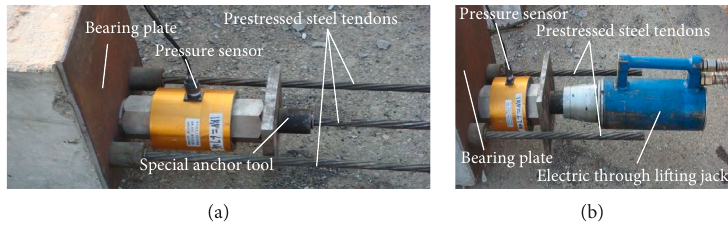
Figure 4: Prestressed tendon setup. (a) Anchor end. (b) Stretched end.